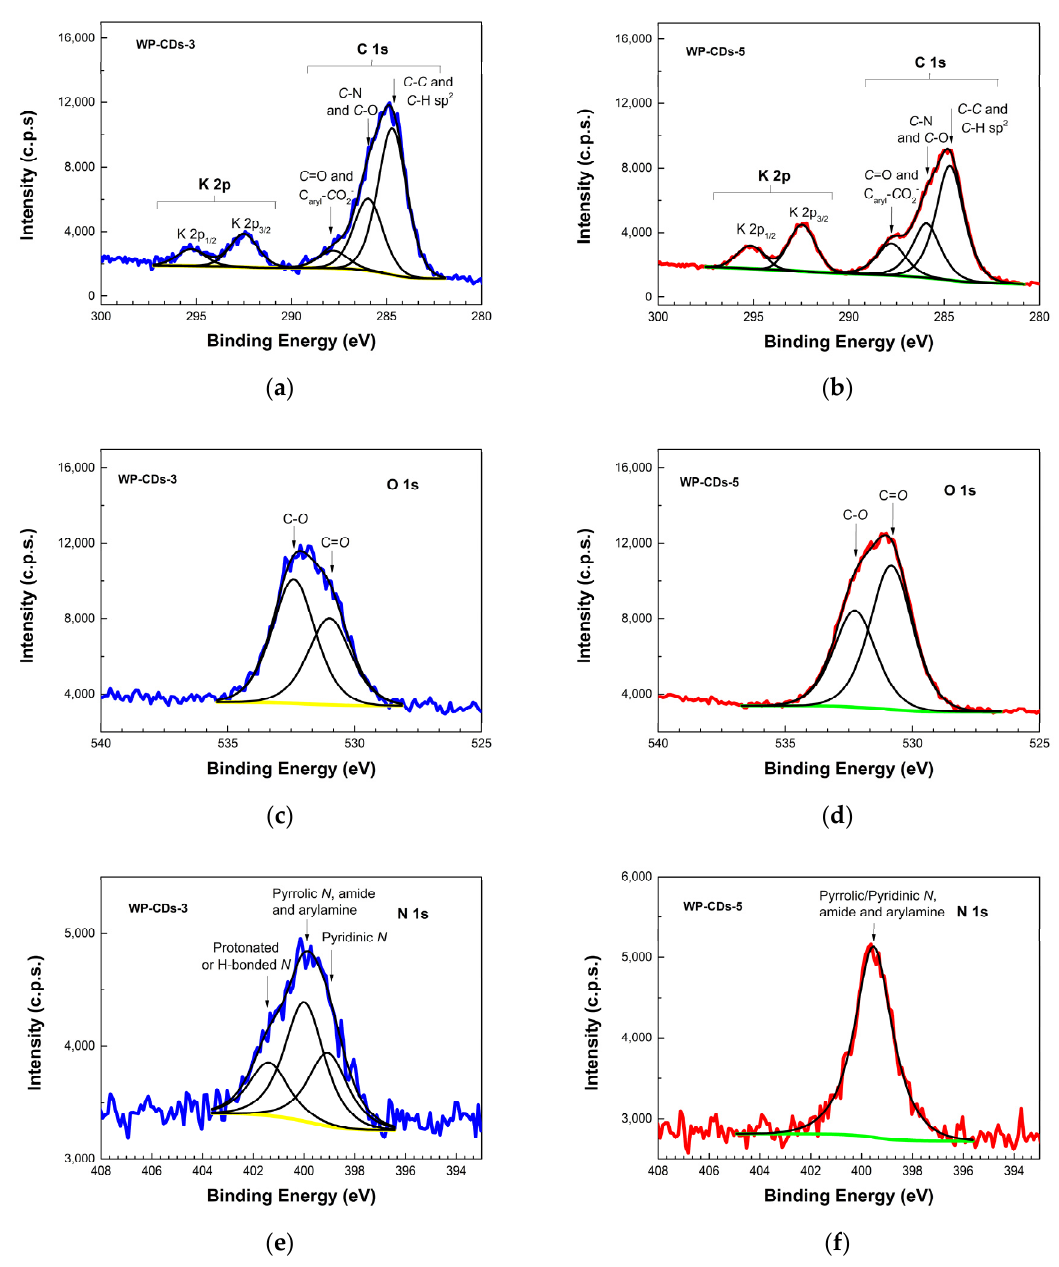
Figure 4. XPS spectra of WP-CDs-3 ( a , c , e) ; blue lines and WP-CDs-5 ( b , d , f) ; red lines showing C 1s and K 2p ( a , b ), O 1s ( c , d ), and N 1s ( e , f ) regions.